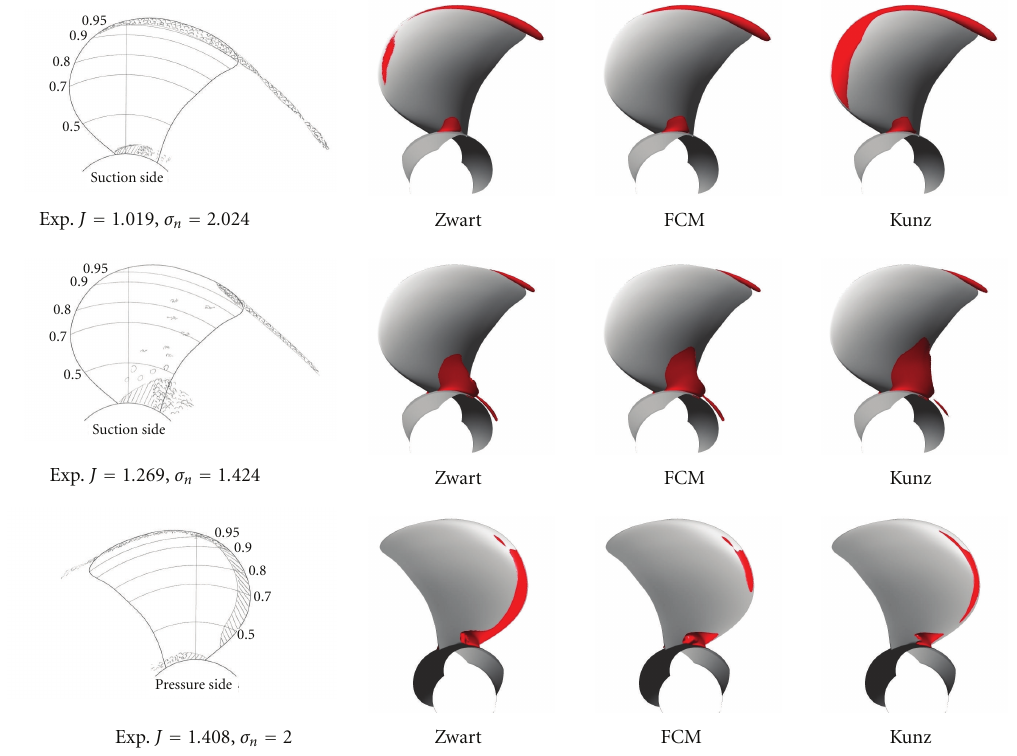
Figure 14: Comparison of the cavitation patterns for three di ff erent operational conditions for the PPTC propeller. The numerical cavitation patterns, obtained using the three di ff erent mass transfer models, are depicted as isosurfaces of vapour volume fraction α = 0 . 5.